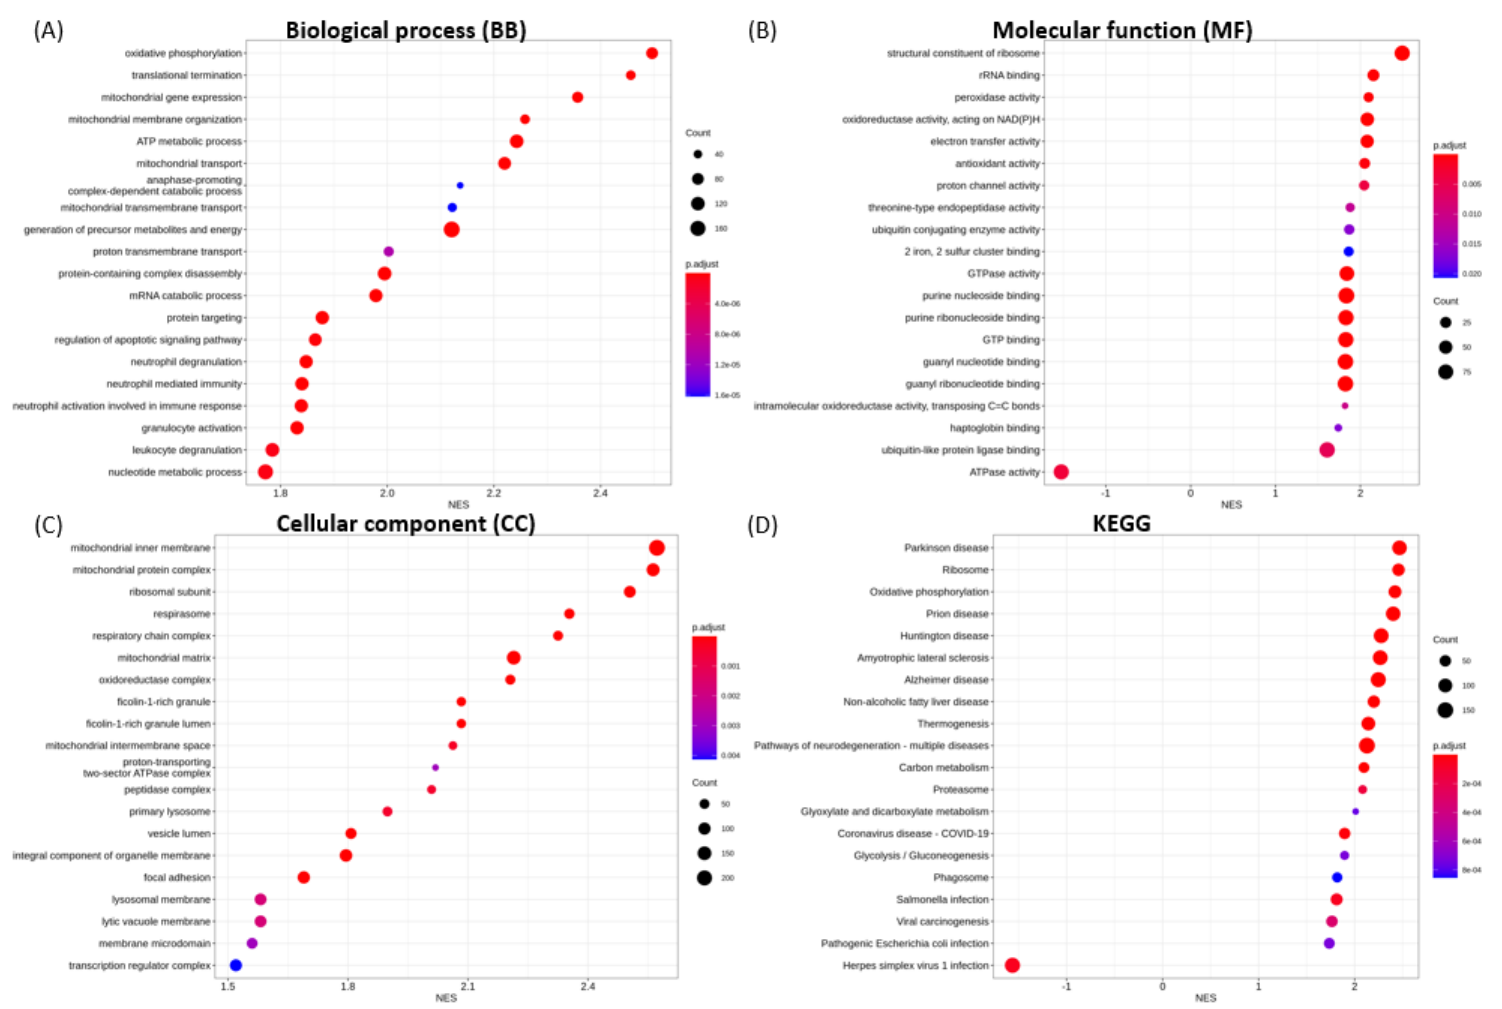
Figure 6. GSEA enrichment for SARS-CoV-2 NSP15 transfection illustrating the top 20 most significantly enriched terms for ( A ) BP, ( B ) MF, ( C ) CC and ( D ) KEGG pathways, in decreasing order based on normalized enrichment score